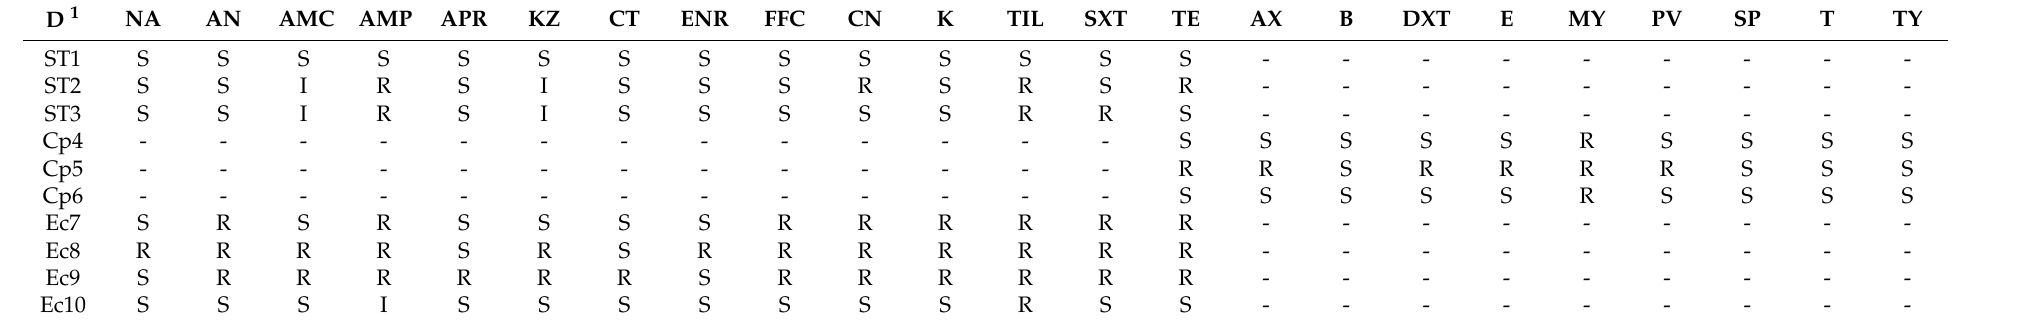
Table 3. Sensitivity of strains to antibiotics.